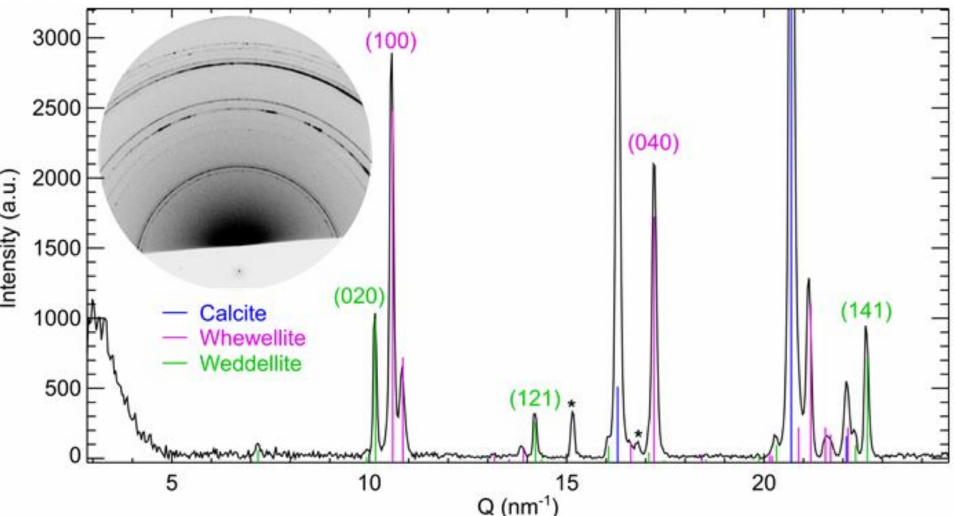
Figure 1. Diffractogram obtained on sample VES_A5_3 after an exposure of 10 s showing the presence of calcite ( blue ), weddellite ( green ), and whewellite ( pink ). The Miller indices for the reflections of weddellite and whewellite that are used for the calculation of the layer thickness and penetration depth are given. The ‘*’ symbols indicate diffraction signals originating from the dried glue. The inset shows the corresponding 2D diffraction image. The lower intensity in the bottom part of the diffraction image is due to a lead foil that was added to protect the detector from the